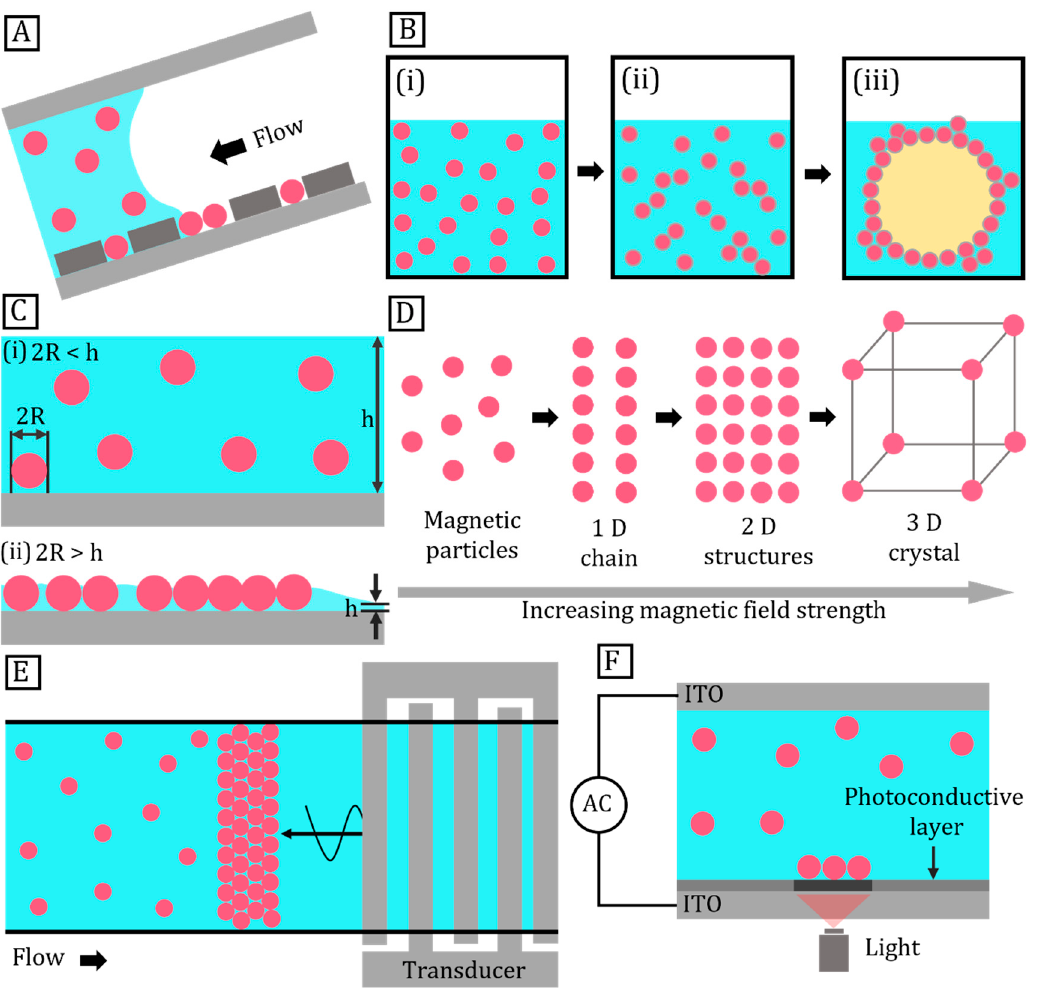
Figure 4. Assembly of micro- and nanoparticles. ( A ) Assembly of particles on patterned surface; ( B ) Formation of core–shell particles with layer-by-layer assembly on Pickering emulsion surfaces: ( i ) Poly (sodium styrene sulfonate) particles suspended in water, ( ii ) Surface modification, ( iii ) Emulsification to form oil-in-water Pickering emulsion; ( C ) 2D assembly of particles suspended in a medium: ( i ) Random arrangement of particles in thick layer of medium, ( ii ) Particles assembly into 2D as medium evaporates; ( D ) Suspended magnetic particles successively arrange into 1D chain, 2D sheet, and 3D crystal with increasing magnetic field strength and particle concentration; ( E ) Assembly of suspended particles in a microfluidic channel using surface acoustic wave; ( F ) Experimental setup of optofluidic assembly of particles.